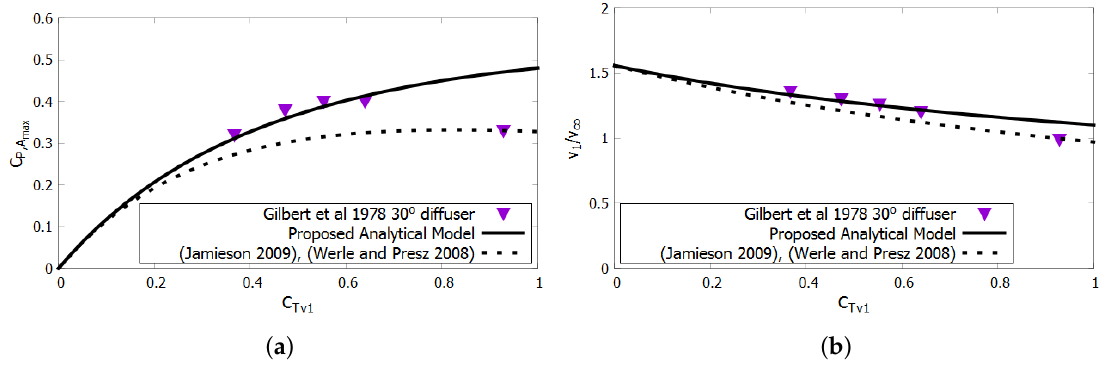
Figure 8. Analytical predictions along with the screen tests of Gilbert et al. [2]. ( a ) C P , A ( b ) v 1 / v ∞ vs. C Tv